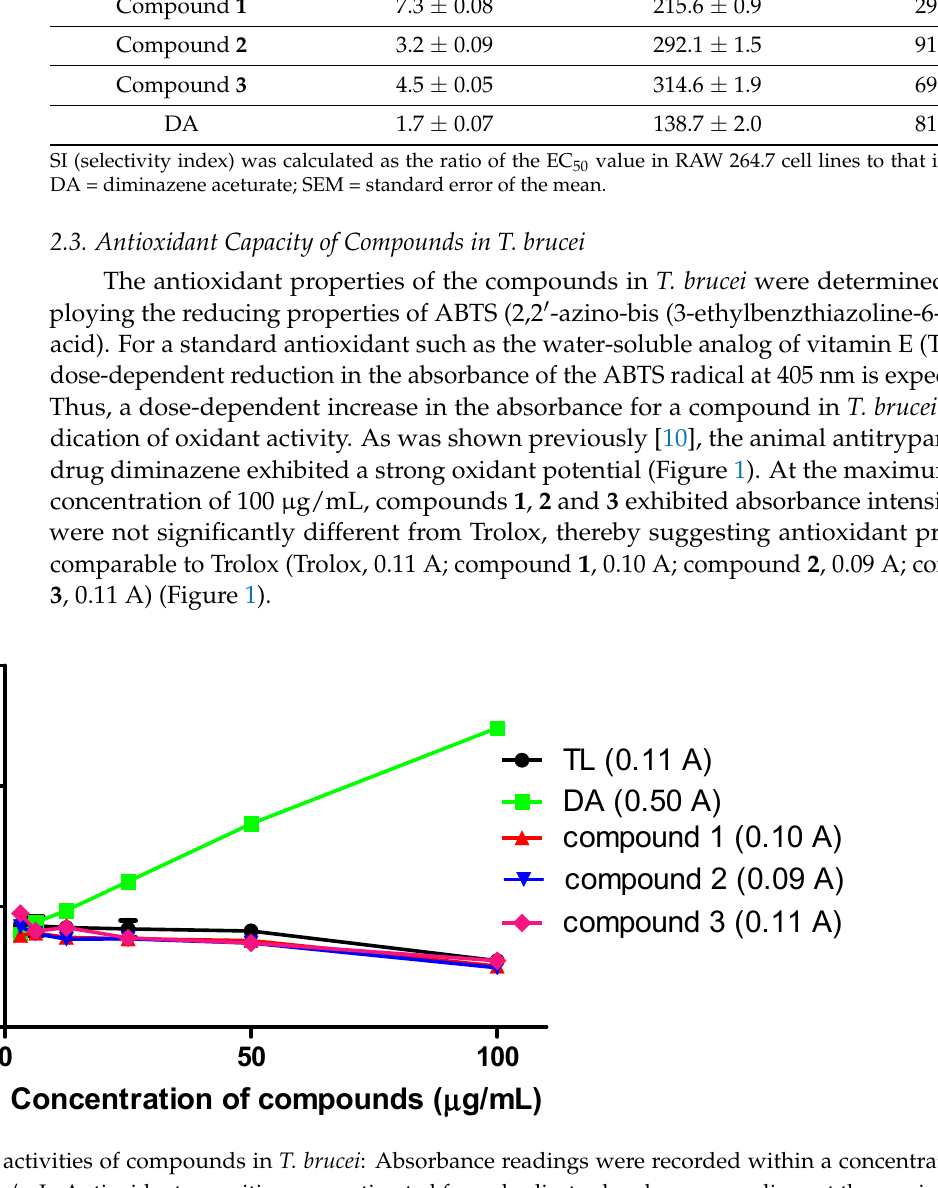
Figure 1. Antioxidant activities of compounds in T. brucei : Absorbance readings were recorded within a concentration range of 3.125 to 100 µ g/mL. Antioxidant capacities were estimated from duplicate absorbance recordings at the maximum observed concentration of 100 µ g/mL using the Trolox curve as the standard antioxidant. DA = Diminazene aceturate; TL = Trolox; A = absorbance units at 100 µ g/mL.